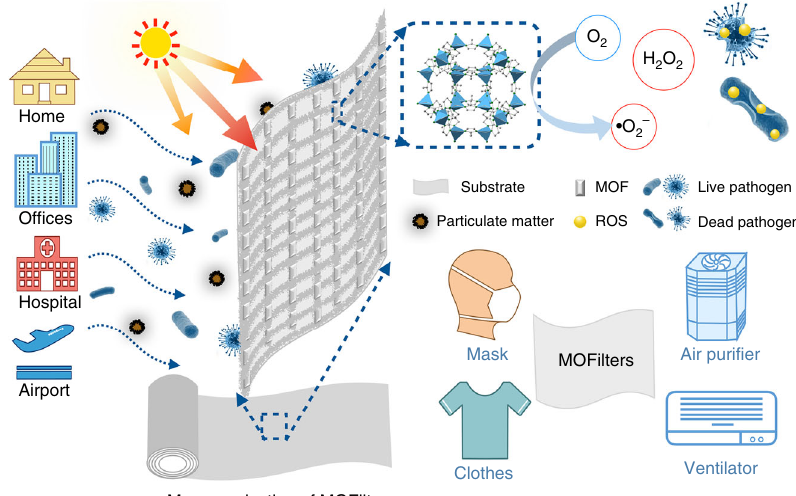
Fig. 1 Schematic of metal-organic framework (MOF)-based fi lter. Schematic representation of MOF-based fi lter (MOFilter) for integrated air